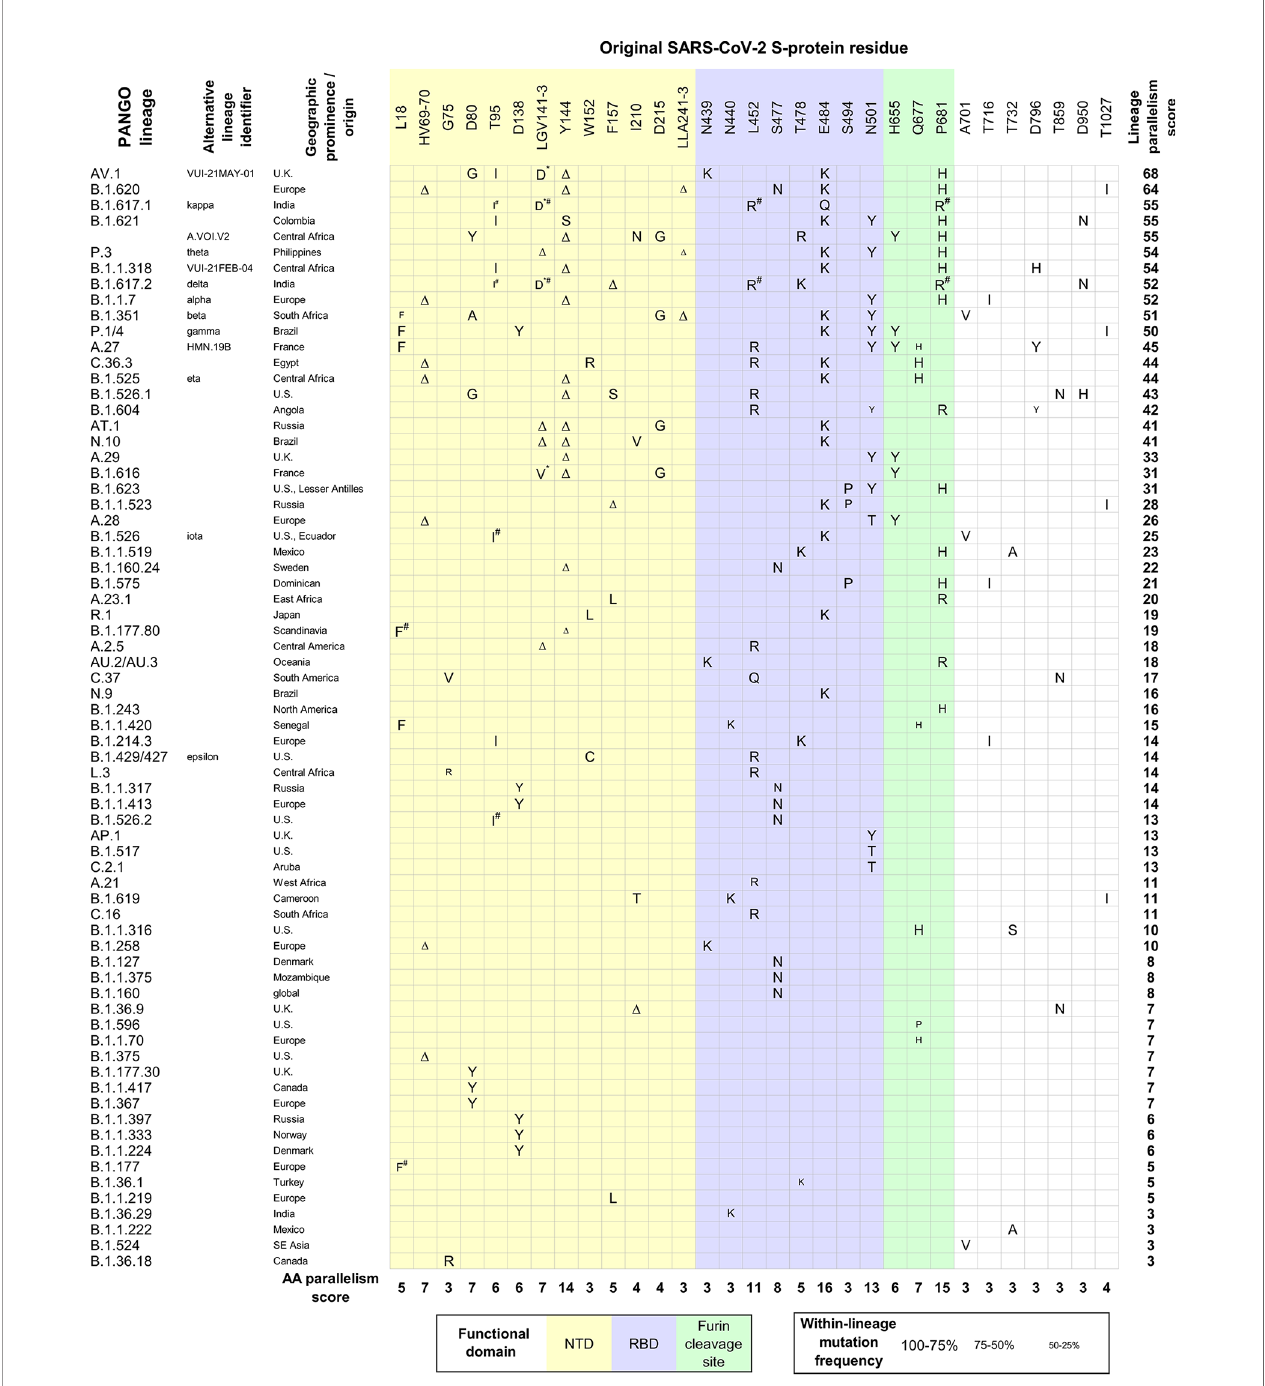
FIGURE 1 | Convergent evolution of SARS-CoV-2 S-protein AA residues among different lineages (autumn 2020 – spring 2021). All S-protein AA mutations present in SARS-CoV-2 VOC lineages (alpha, beta, gamma, delta) were collected. The phylogenetic pattern of mutations at each of these AA positions was assessed visually in the representative global subsample of SARS-CoV-2 genomes (https://nextstrain.org/ncov/global) (Had fi eld et al., 2018). NextStrain was scanned repeatedly between March to June 2021;lineages were con fi rmed to show a recent localized rise to high frequency (indicative of selective advantage). All additional S-protein AA mutations present in these lineages were subjected to the same procedure as above. After several iterations, a fi nal set of S-protein positions that experienced ≥ 3 independent mutations was established. Information about the distribution and within-lineage frequency of S-protein mutations, and the spatiotemporal characterization of SARS-CoV-2 lineages was retrieved from (Tsueng et al., 2022) (15 June 2021). The AA parallelism score was established for all convergently mutated AAs, by summing their independent emergence events. The lineage parallelism score was calculated by summing the parallelism scores of S-protein AAs mutated in individual lineages. *AA substitutions for G142; Mutations inherited from the same progenitor are considered a single evolutionary origin in parallelism score